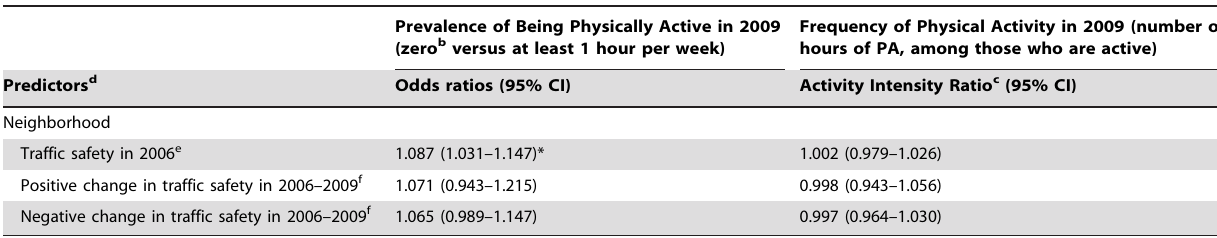
Table 4. Association of physical activity in 2009 with traffic safety in 2006 and the degree of positive or negative change in traffic safety between 2006 and 2009, for 2009 respondents a